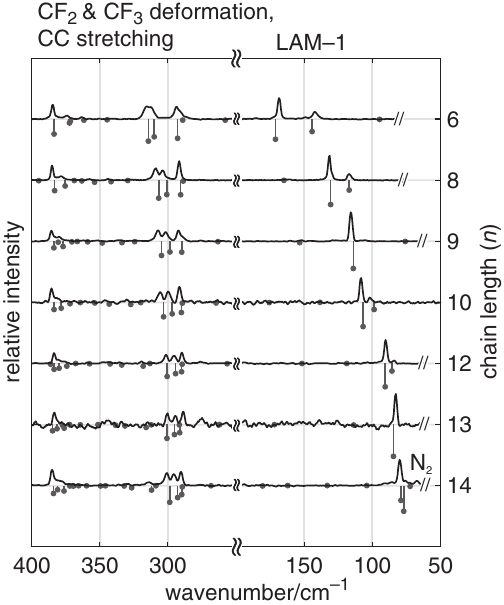
Figure 2. Raman jet spectra of per fl uorinated alkanes expanded in helium. Calculated harmonic wavenumbers and scattering cross-sections (all-anti, B3LYP-D3/def2-TZVP, unscaled, T = 100 K) are given as gray inverted stems.